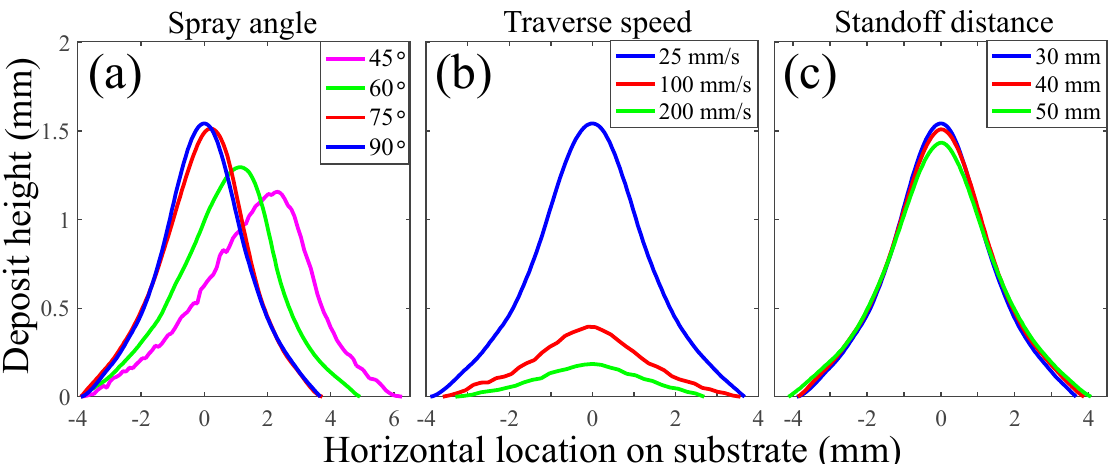
Figure 1. ( a ) the effect of spray angle at 25 mm traverse speed and 30 mm standoff distance (45°— sample 1, 60° — sample 2, 75° — sample 3, 90° — sample 4), ( b ) the effect of traverse speed at 90° spray angle and 30 mm standoff distance (25 mm/s — sample 4, 100 mm/s — sample 8, 200 mm/s — sample 12) and ( c ) the effect of standoff distance at 90° spray angle and 25 mm/s traverse speed (30 mm — sample 4, 40 mm — sample 16, 50 mm — sample 28).